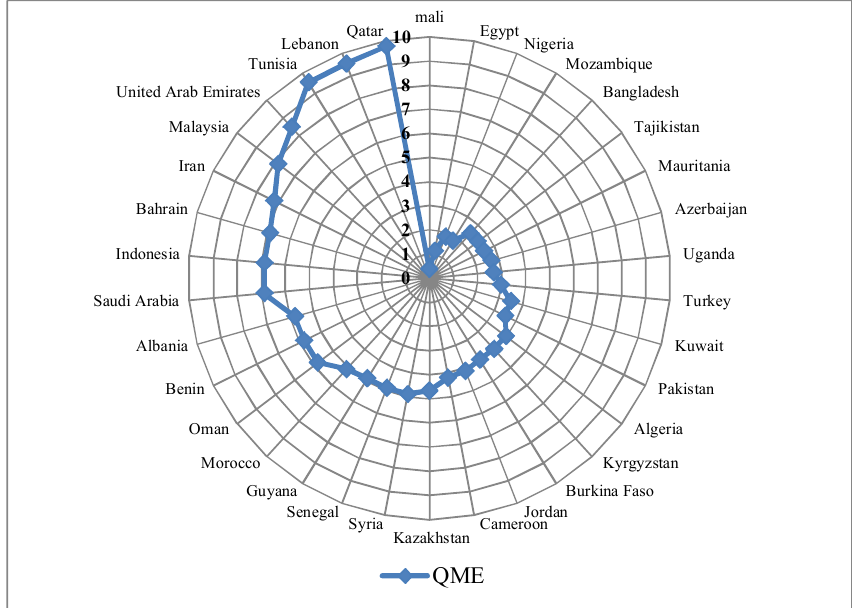
Fig. 1. Position of QME in OIC countries